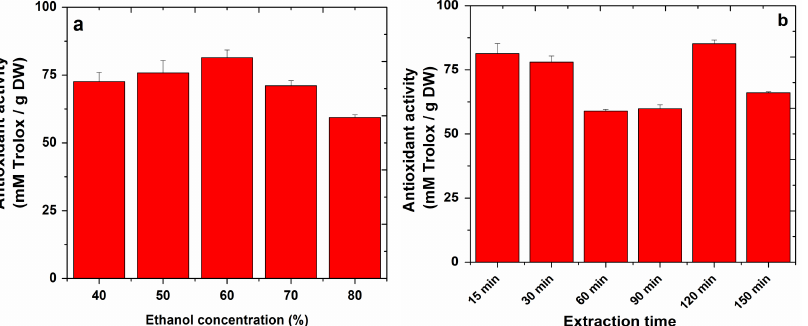
Figure 5. DPPH radical scavenging activity of apple extracts obtained by refluxing in different conditions: ethanol concentration ( a ) and extraction time ( b ).